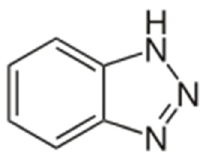
Figure 1. Chemical structure of benzotriazole (BTA, C 6 H 5 N 3 ).